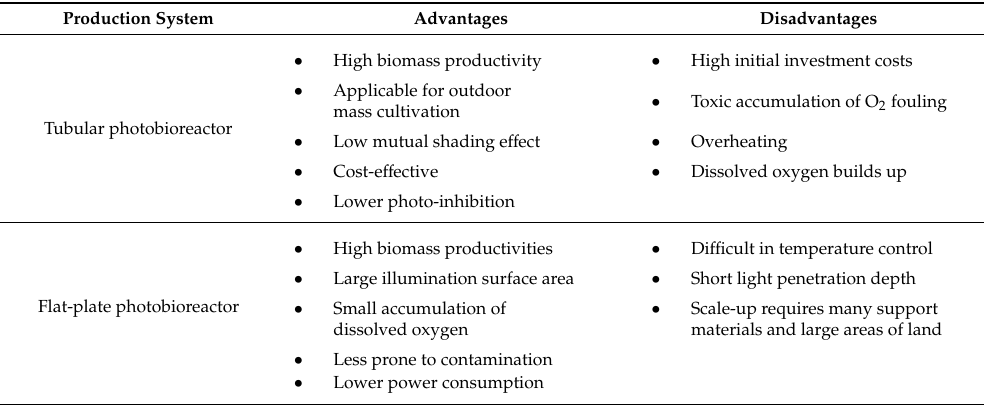
Table 4. Comparison of tubular and flat-plate photobioreactors